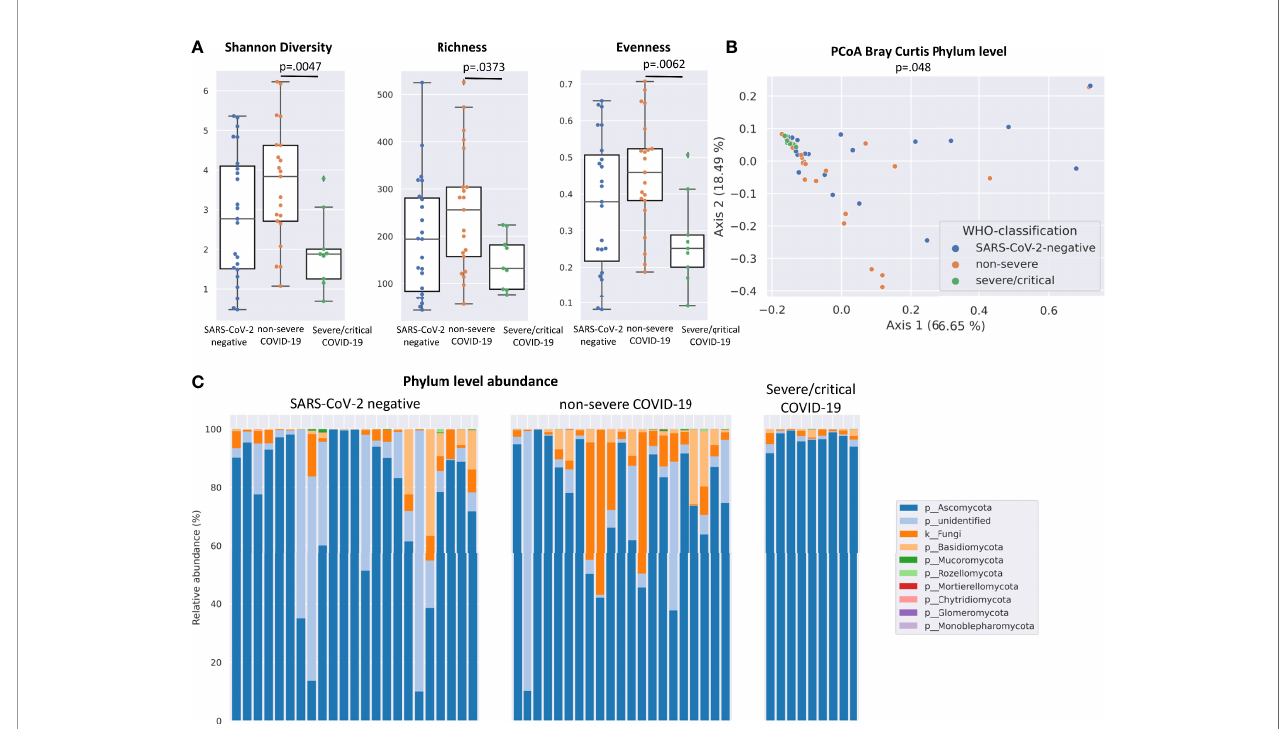
FIGURE 1 | Differences in the fungal gut microbiome in SARS-CoV-2 negative patients and patients with non-severe and severe/critical COVID-19 illness. (A) Shannon diversity, richness and evenness of the fungal gut microbiome. Kruskal-Wallis test was used to test for signi fi cant differences between groups. (B) Principal Coordinates Analysis (PCoA) of phylum level distance matrix. PERMANOVA multivariate analysis was used to test for signi fi cant differences between groups. (C) Relative phylum level abundance of the fungal gut microbiome in individual SARS-CoV-2 negative patients, patients with non-severe and severe/critical COVID-19.